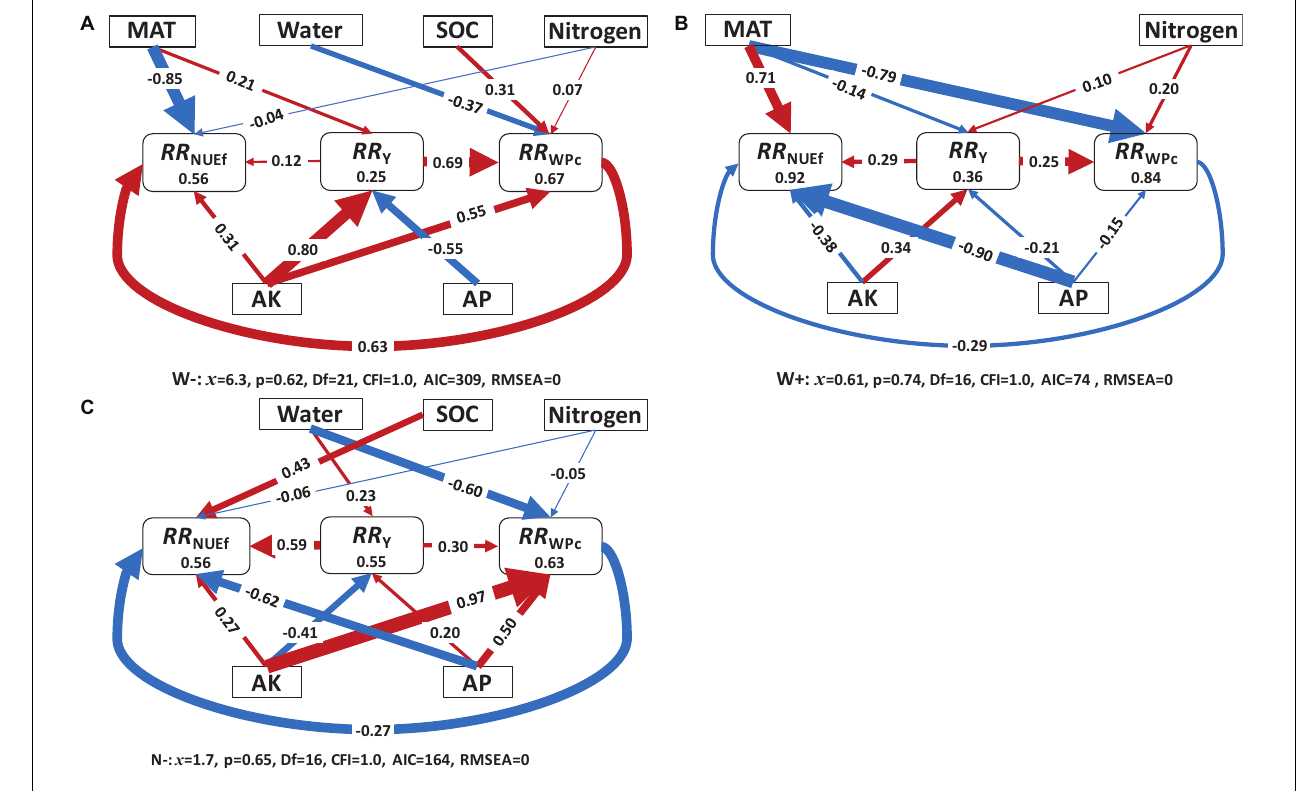
FIGURE 3 | Structural equation model showing the direct and indirect effects of environmental and management conditions on the response ratio of yield ( RR Y ), water productivity ( RR WPc ), and fertilizer nitrogen use efficiency ( RR NUEf ) under (A) below-optimal water inputs (W - ), (B) above-optimal water inputs (W + ), and (C) below-optimal N inputs (N − ). Results under the above-optimal N inputs (N + ) were not shown due to data paucity. Numbers in the box indicate the variance explained by the model ( R 2 ). Numbers at arrows are standardized path coefficients. The width of the line indicates relative statistical significance (the thicker the